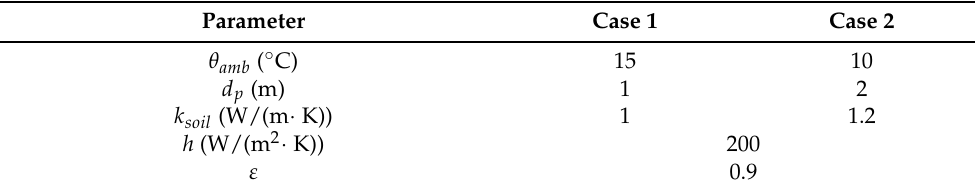
Table 3. Thermal boundary